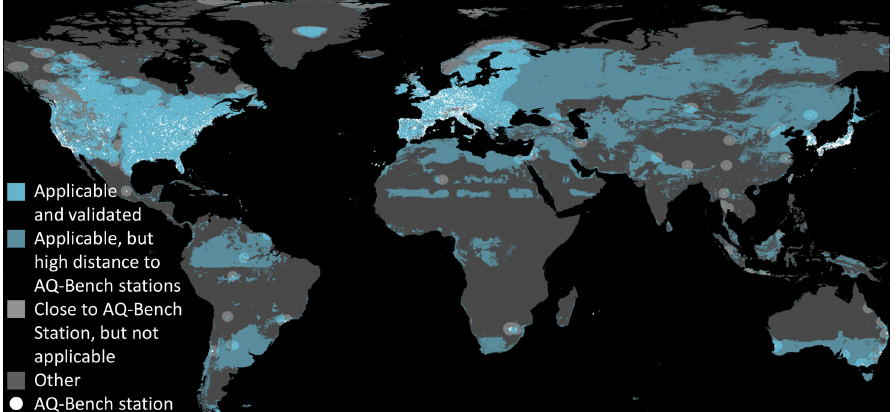
Figure 6. Area of applicability with restrictions in the feature space and spatial restrictions. The bright turquoise areas fulfill all prerequisites to be predictable: they have similar features as the AQ-Bench dataset and they are close to stations for validation. The darker shade of turquoise indicates similar predictions but no proximity to stations for validation. Light gray areas indicate the proximity of a station but no applicability of the model. The locations of all measurement stations are plotted in